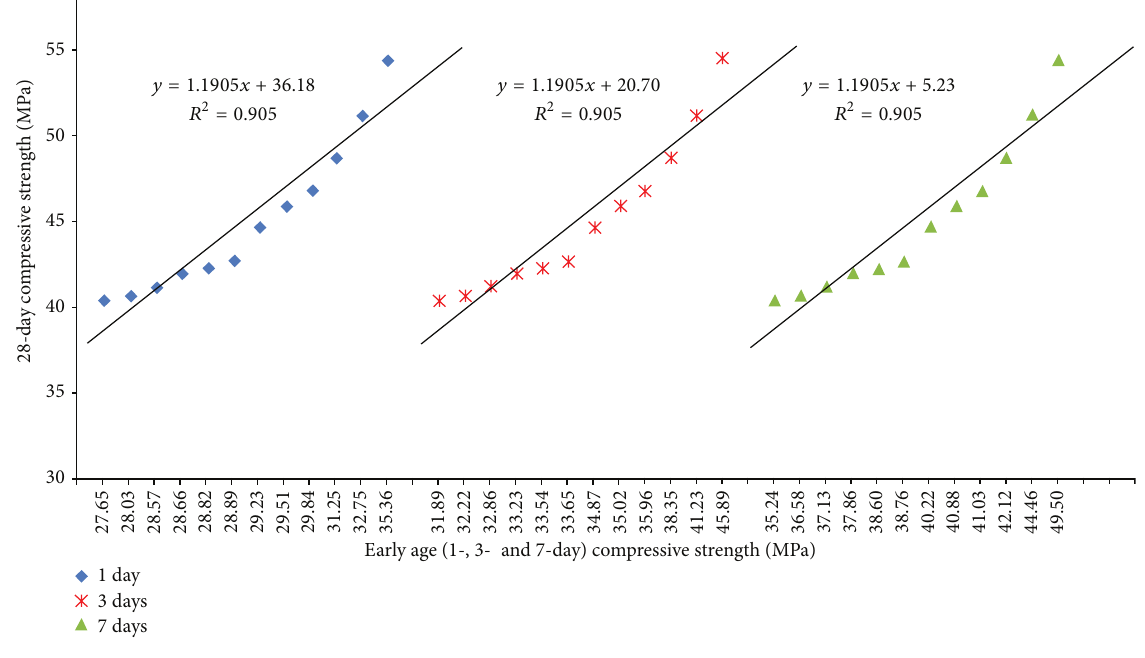
Figure 9: Effect of curing conditions on the 28-day compressive strength of concrete mixes.